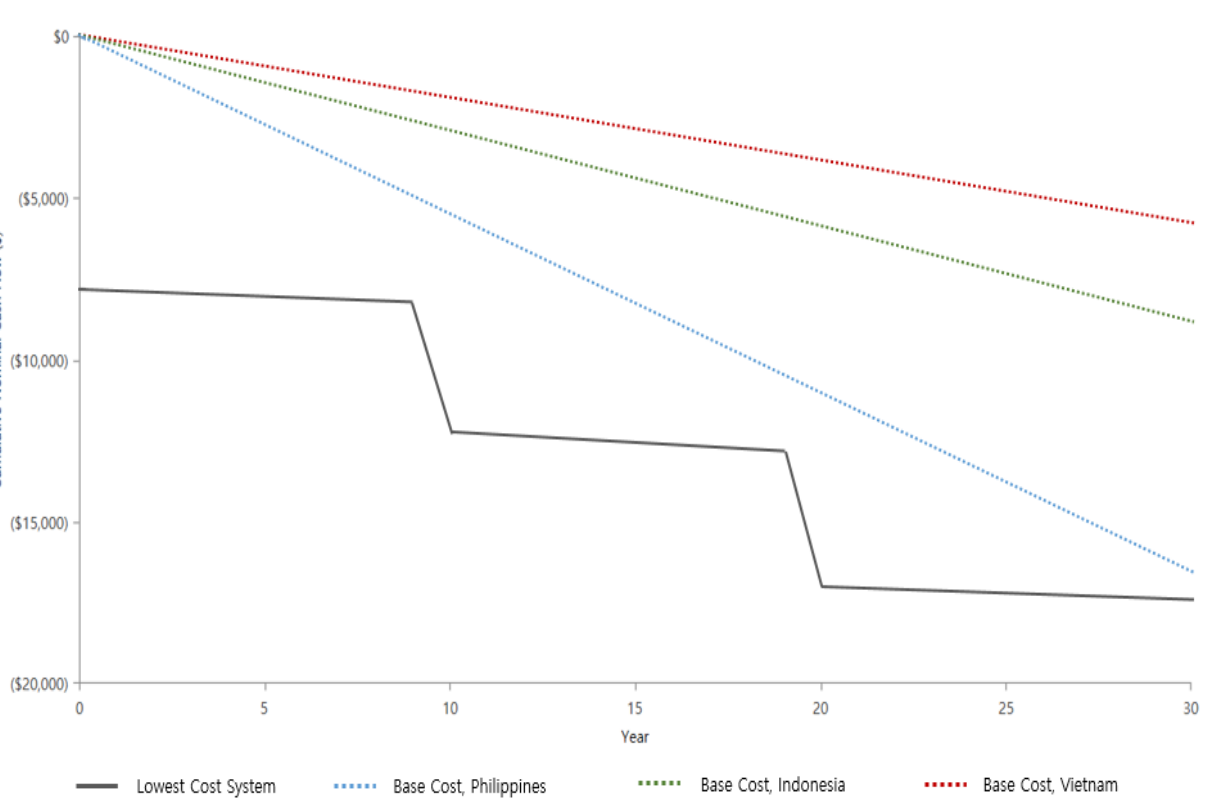
Figure 7. Economic feasibility of the proposed system compared with that of Base 2 system for the three countries.